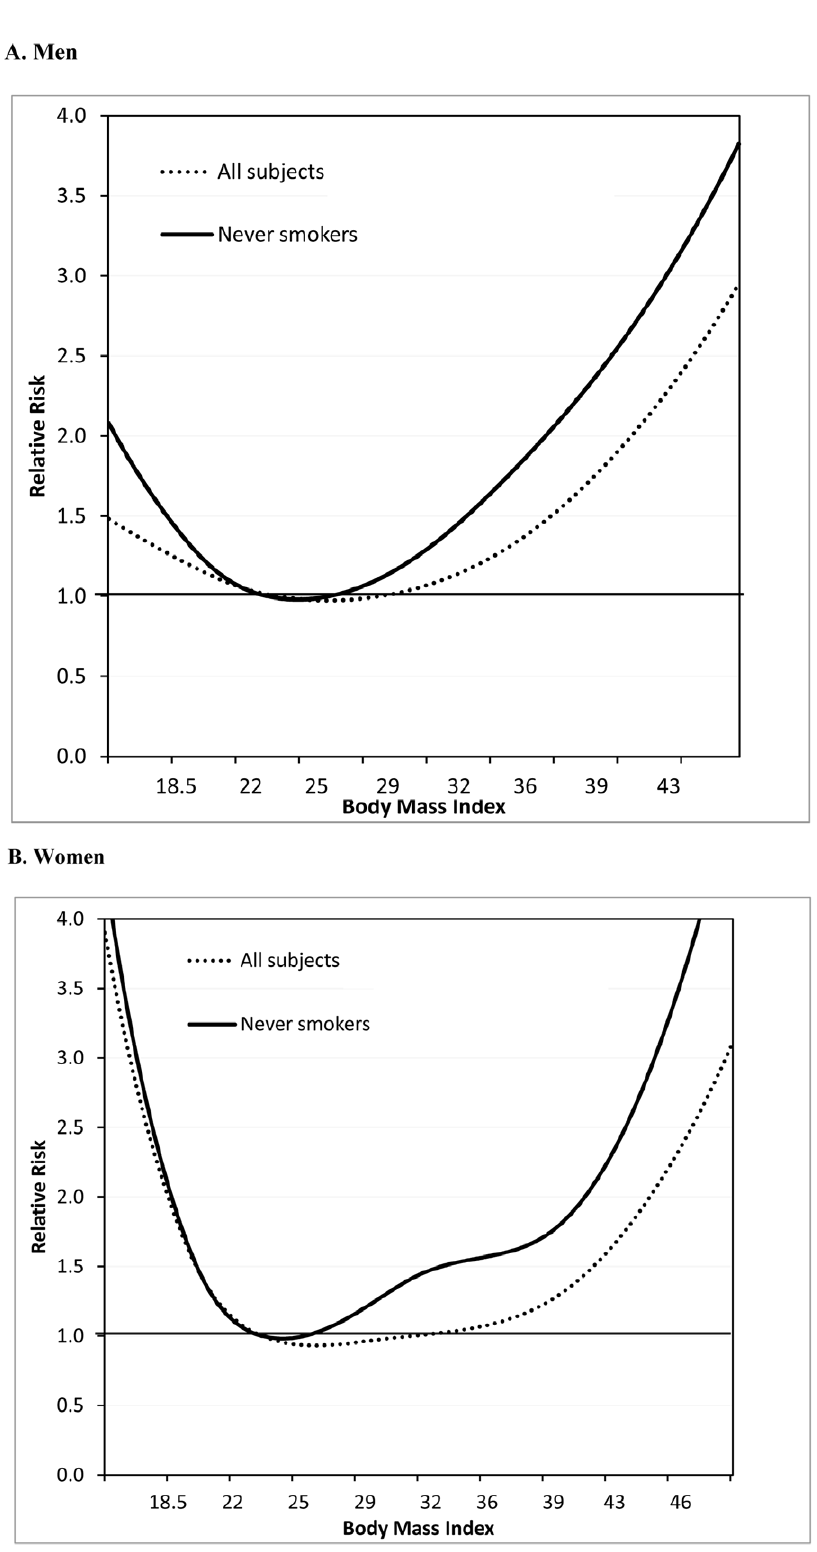
Figure 1. Relative risk for total mortality in non-Hispanic black men and women a, b, c . a. Subjects who did not have any prevalent cancer except non-melanoma skin cancer or heart disease at baseline b. Adjusted for age, education, marital status, smoking status, time since quitting smoking, number of cigarettes per day, physical activity, alcohol consumption, and menopausal hormone therapy use in women. Analysis of never smokers with no history of diseases at baseline was adjusted for same covariates except smoking status, time since quitting smoking, number of cigarettes per day. c. Men, 1,347 deaths in subjects with no history of disease and 288 deaths in never smokers with no history of diseases: Women, 1,262 deaths in subjects with no history of disease and 425 deaths in never smokers with no history of diseases. doi:10.1371/journal.pone.0050091.g001 PLOS ONE | www.plosone.org